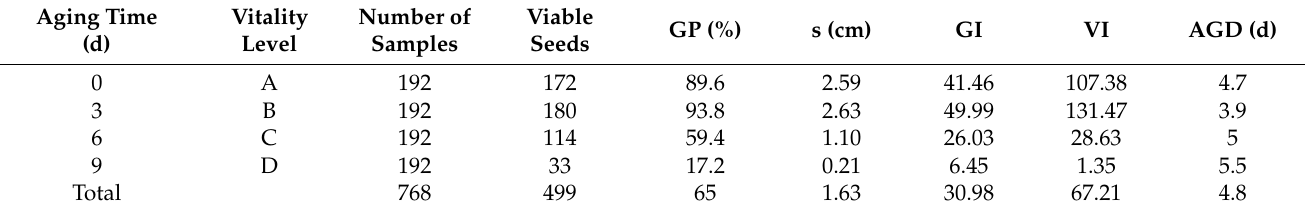
Table 1. Germination test to determine seed viability in all